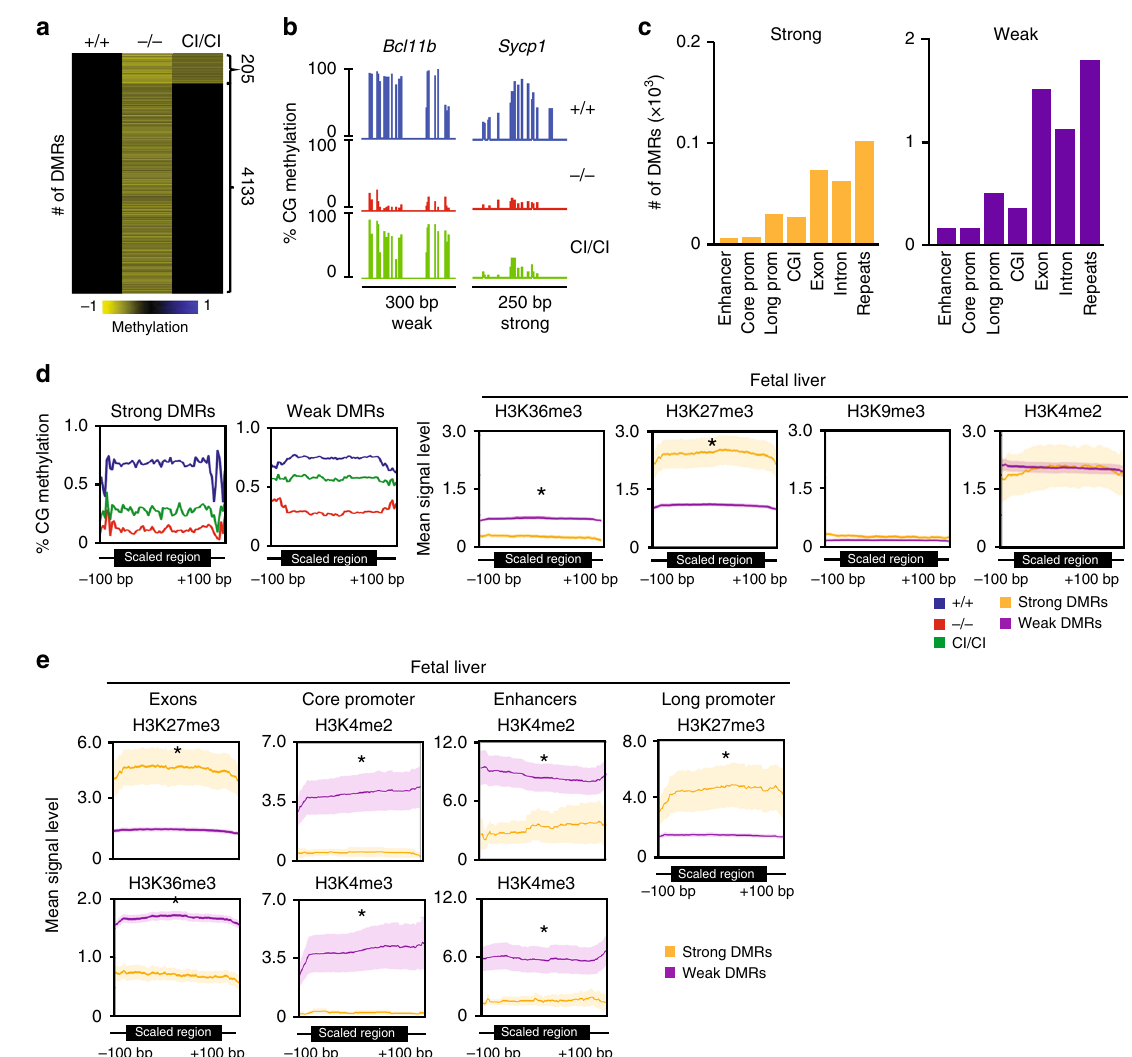
Fig. 4 Association of histone modi fi cations with Dnmt3b-dependent DNA methylation. a Differential requirement of DMRs on catalytic activity of Dnmt3b. Heat map presenting a subset of hypomethylated DMRs ( n = 205) identi fi ed in E11.5 Dnmt3b − / − relative to Dnmt3b + / + depends strongly on catalytic activity of Dnmt3b because their hypomethylation is not rescued to wild-type levels in Dnmt3b CI/CI E11.5 embryos (termed here strong). In contrast, DMRs hypomethylated in both E11.5 Dnmt3b − / − and Dnmt3b CI/CI relative to wild type depend on accessory rather than catalytic activity of Dnmt3b and are termed here weak ( n = 4133). b DNA methylation scores obtained for Bcll11b (weak DMR) and Sycp1 (strong DMR) from RRBS analysis of Dnmt3b + / + , Dnmt3b − / − and Dnmt3b CI/CI embryos at E11.5 as visualized by IGB. c Distribution of strong and weak DMRs among indicated genomic elements. d Enrichment of strong DMRs and weak DMRs for chromatin marks in E11.5 Dnmt3b + / + embryos as detected by analysis of ChIP-seq (ENCODE). Averaged DNA methylation levels± SEM for scaled regions of DMRs are shown for strong ( n = 205) and weak DMRs ( n = 4133) ( fi rst two panels). Mean levels ± SEM of four histone marks showing signi fi cant differences of enrichment between strong and weak DMRs are presented in the right panel. Plots shows pro fi les for DMRs scaled to same length and surrounding 100 bp unscaled regions. * p < 0.05 by two-tailed Student ’ s t -test. SEM values are presented as shading around mean value line. e Enrichment of strong and weak DMRs in enhancers, exons, core, and long promoters for signi fi cantly different chromatin marks in Dnmt3b + / + embryos at E11.5 as detected by analysis of ChIP-seq from data obtained from ENCODE. Mean levels of histone marks showing signi fi cant differences of enrichment between strong and weak DMRs are presented. Plots shows pro fi les for DMRs scaled to same length and